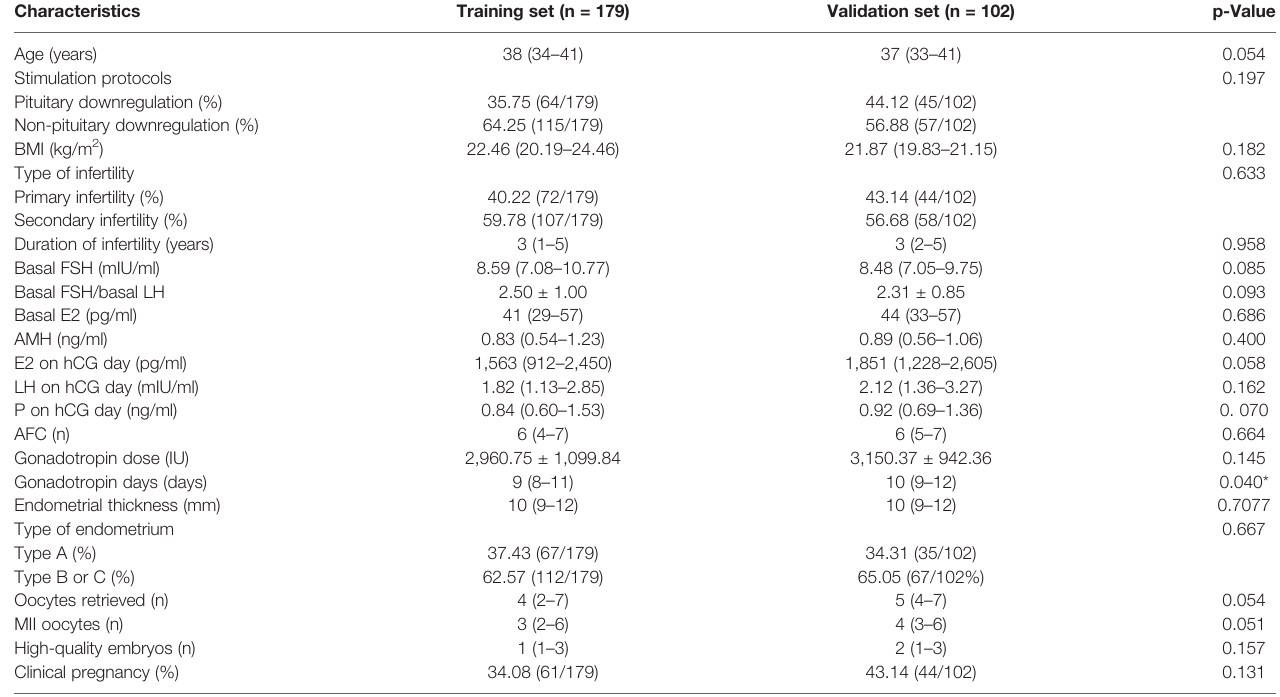
TABLE 1 | Basic characteristics of PORs in the training and validation cohorts.